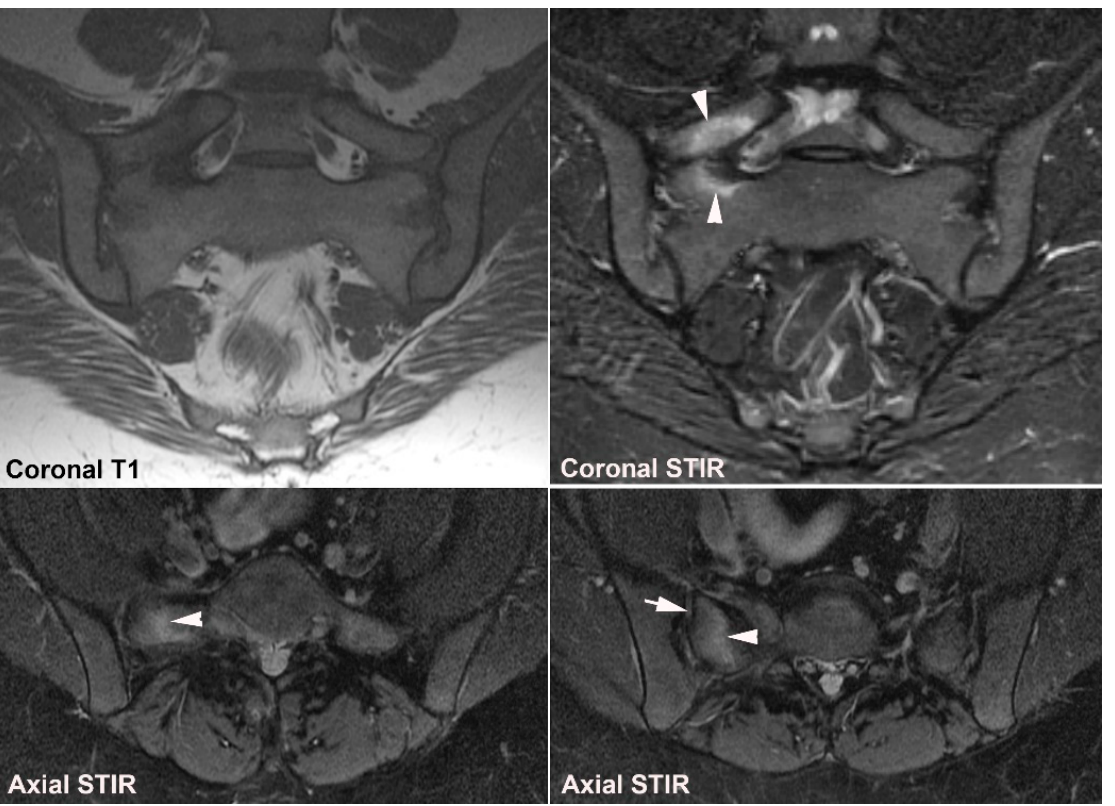
Figure 14. Transitional vertebra, MRI in a 33-year-old man with inflammatory right-sided low back pain for 5 months. Semi-coronal T1 and STIR and two semi-axial STIR images, at the level of the transitional vertebra and below in the sacrum. There is lumbarization of S1 with enlarged transverse processes articulating with the upper border of the sacrum (Castellvi type IIB) and pronounced BME around the right-sided pseudo-articulation (arrowheads). On the axial slice at the upper part of the sacrum, the BME reaches the subchondral SIJ area (arrow), but there are no structural changes.